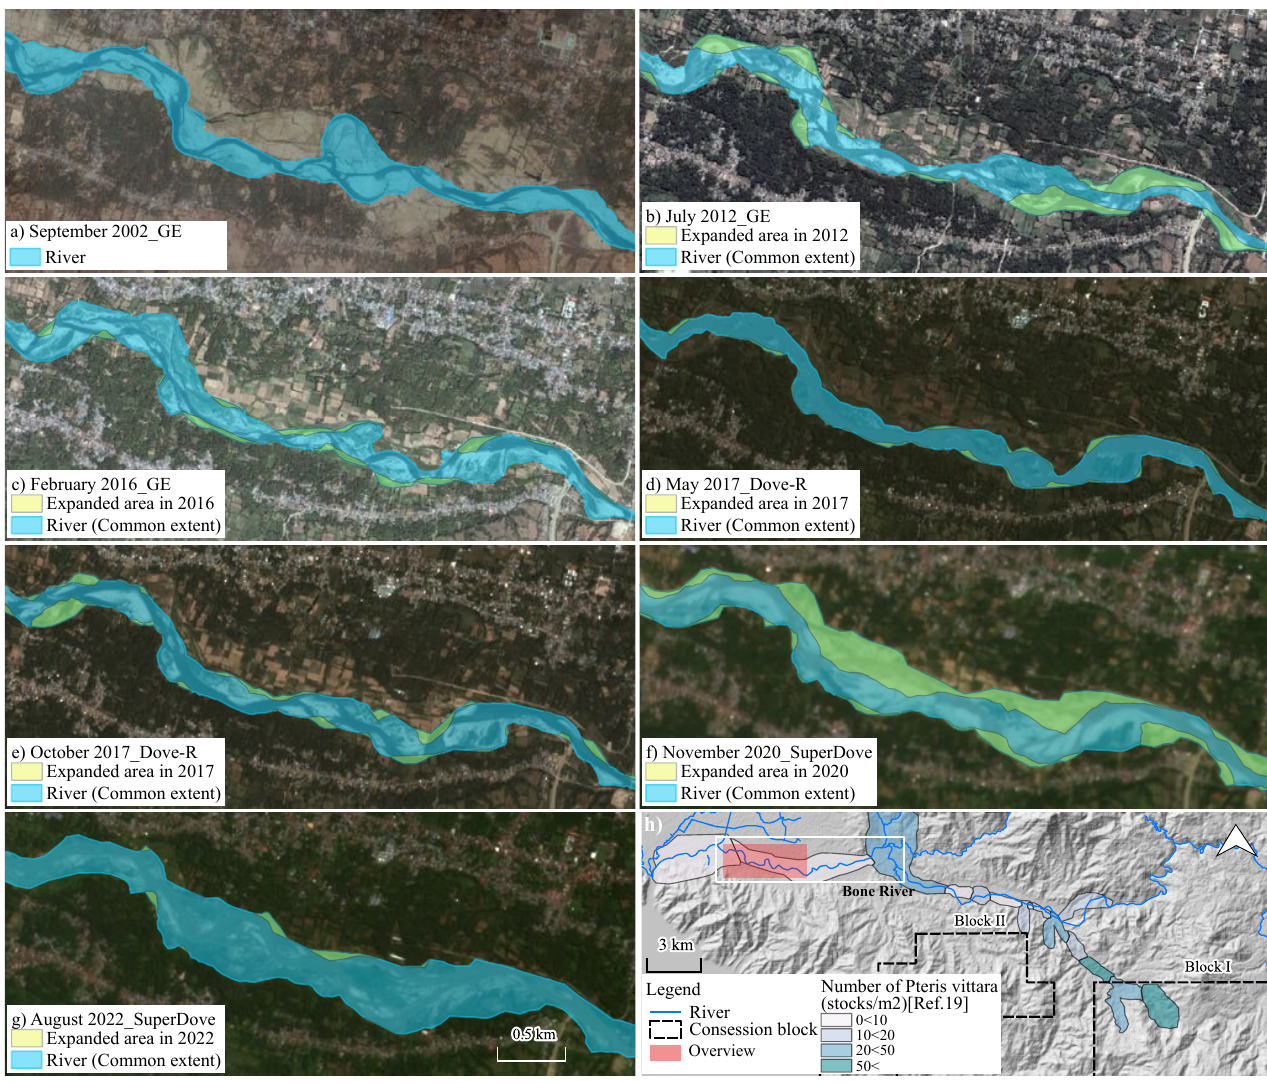
Figure 7. Transformations of west side river extents using PlanetScope series; (a–g) transformations of river extents by highlighting differences (2002–2022); (h) site overview.